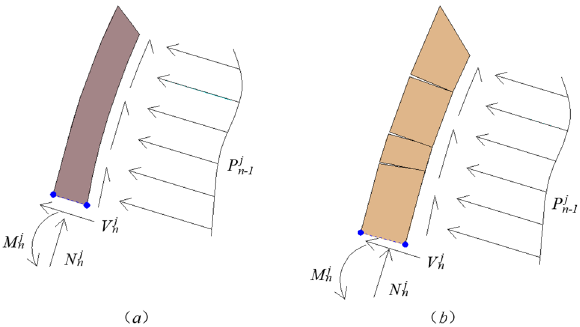
Figure 6. The stress analysis diagram for the first damaged rock